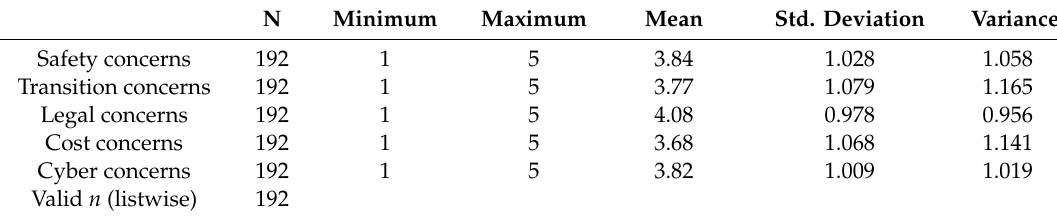
Table 6. Descriptive statistics about the variables concerns.